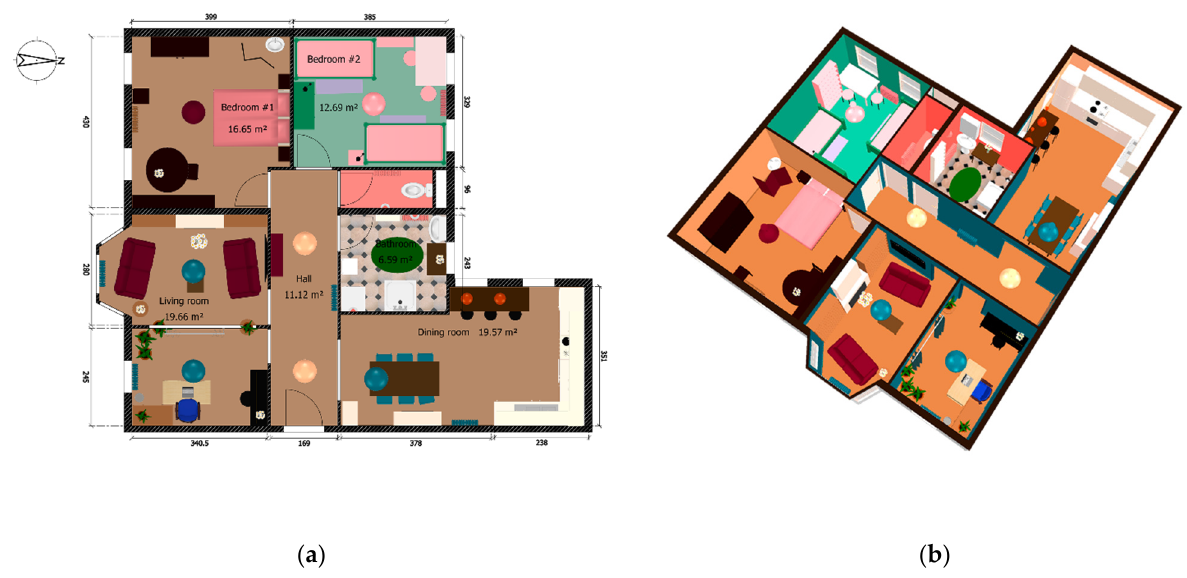
Figure 15. ( a ) Two-dimensional and ( b ) three-dimensional plans of the apartment were made by the designer after revision by the wheelchair user.